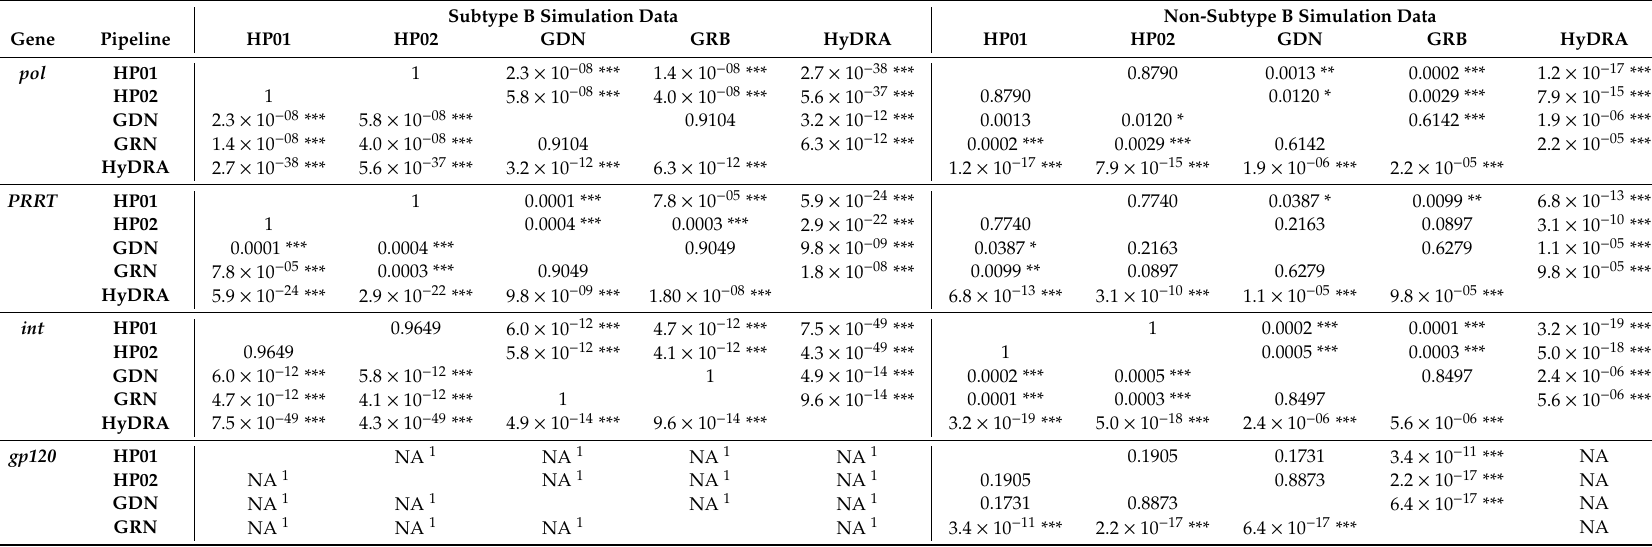
Table A4. Kruskal–Wallis multiple comparisons (Dunn test) of the adjusted genetic p-distance of the pipeline consensus sequence from HXB2, the HIV reference sequence, for the simulation dataset. Adjusted p -values are reported (Holm